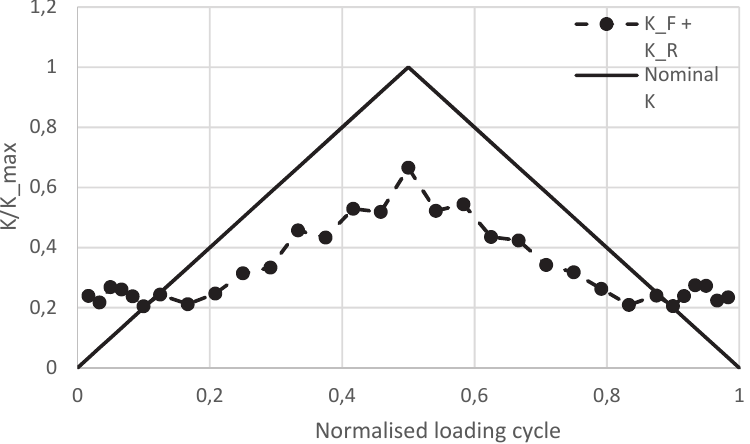
Figure 5: Results from Fig. 4, obtained by Vasco Olmo [8], re-plotted to show the variation of (K F + K R ) with loading cycle